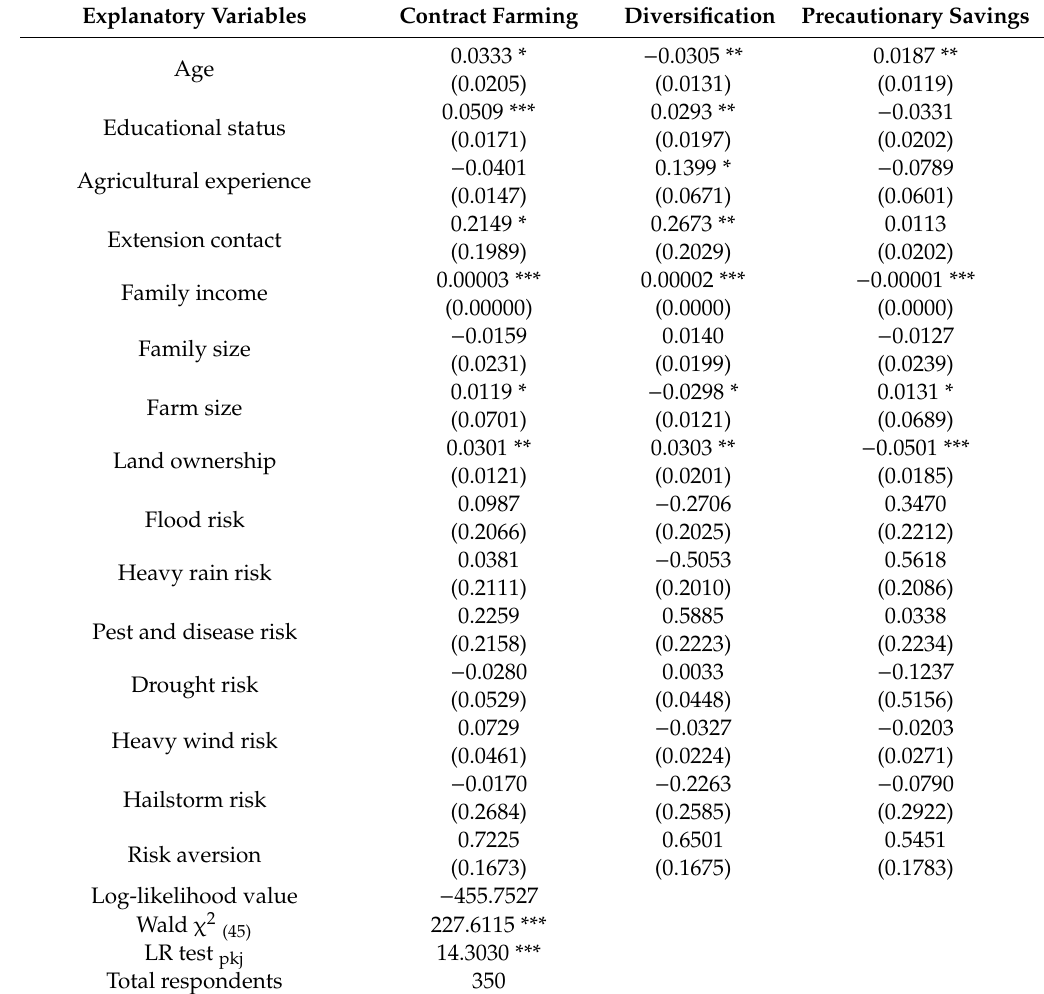
Table 3. Results of the multivariate probit